Question: Briefly state, in one sentence, what is plotted here.
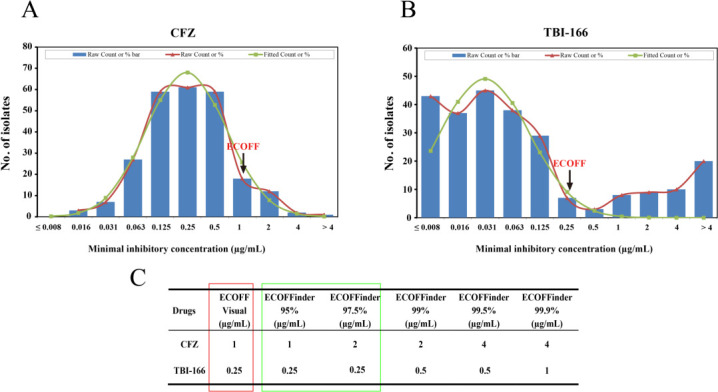
Answer: Nonlinear regression of MIC distribution of CFZ ( A ) and TBI-166 ( B ) to DR-B isolates. ( C ) The abscissa is MIC, the ordinate is the number corresponding to each MIC. The histogram is the original MIC distribution peak, the red curve is the original MIC distribution trend line, and the green curve is the fitting trend line. The arrows indicate the proposed CFZ and TBI-166 ECOFF values for DR-TB isolates. ECOFF, epidemiological cut-off values.